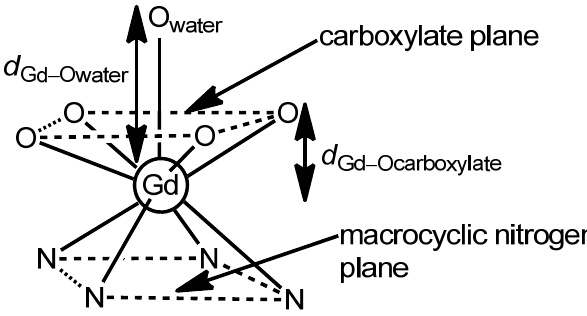
Figure 6. Coordination polyhedron of Gd III -containing complex 43